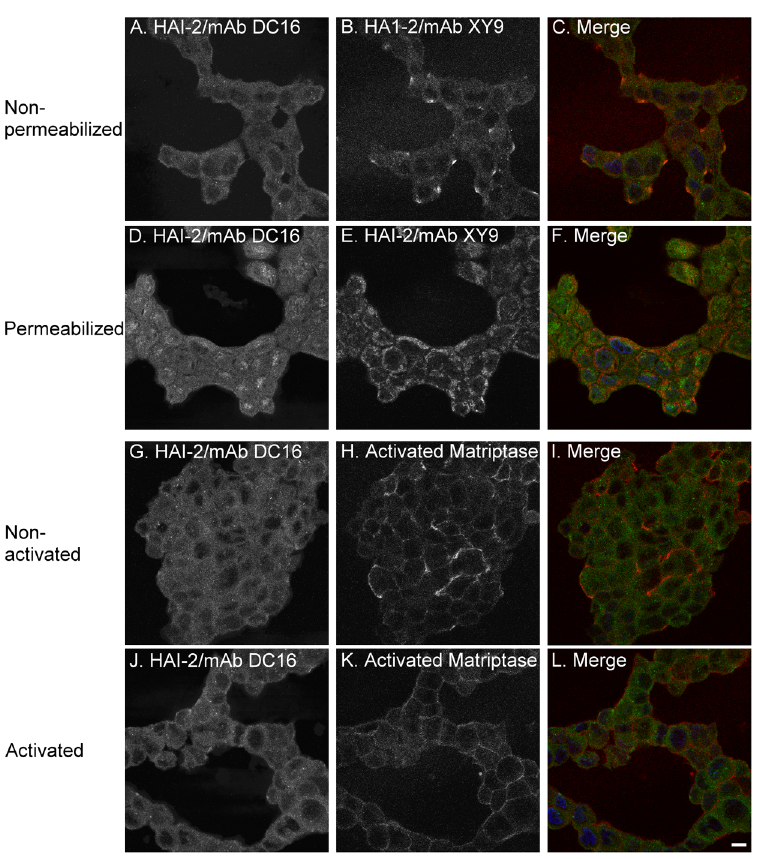
Fig 6. Subcellular localizations of HAI-2 species and activated matriptase in breast cancer cells. The subcellular localizations of HAI-2 species and activated matriptase in T-47D breast cancer cells were analyzed and compared by immunofluorescent double staining using Alexa 488-conjugated mAb DC 16 (green) with mAb XY9 (red) or the activated matriptase mAb M69 (red) after treatment of the cells with or without Triton X-100 to permeabilize the cells following the induction of matriptase zymogen activation by a pH 6.0 buffer exposure, as indicated. The cells were stained for nuclei using DAPI (blue), as a counterstain. The staining is presented as black and white images (A, B, D, E, G, H, J, and K) or merged false-color images (C, F, I and K). Scale bar: 10 μ